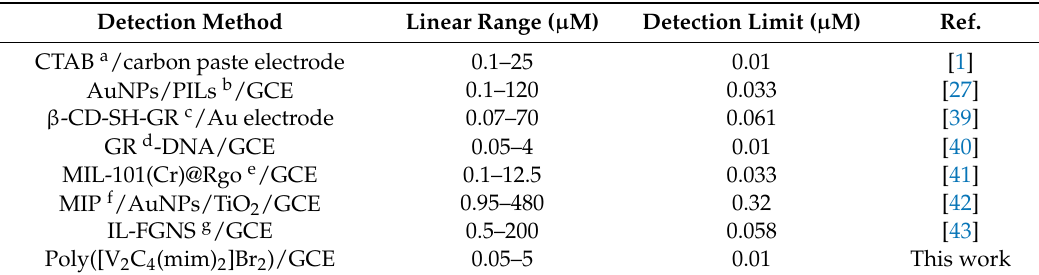
Figure 7. ( A ) Differential pulse voltammograms of poly([V 2 C 4 (mim) 2 ]Br 2 )/GCE for 4-NP from 0 (a), 0.05 (b), 0.1 (c), 0.2 (d), 0.5 (e), 1 (f), 2 (g), 3 (h), 4 (i), 5 (j) µ M. ( B ) Calibration plots for 4-NP with poly(EGDMA)/GCE (a) and poly([V 2 C 4 (mim) 2 ]Br 2 )/GCE (b) ( n = 3). Table 1. Comparison with other electrochemical methods for the determination of 4-NP.